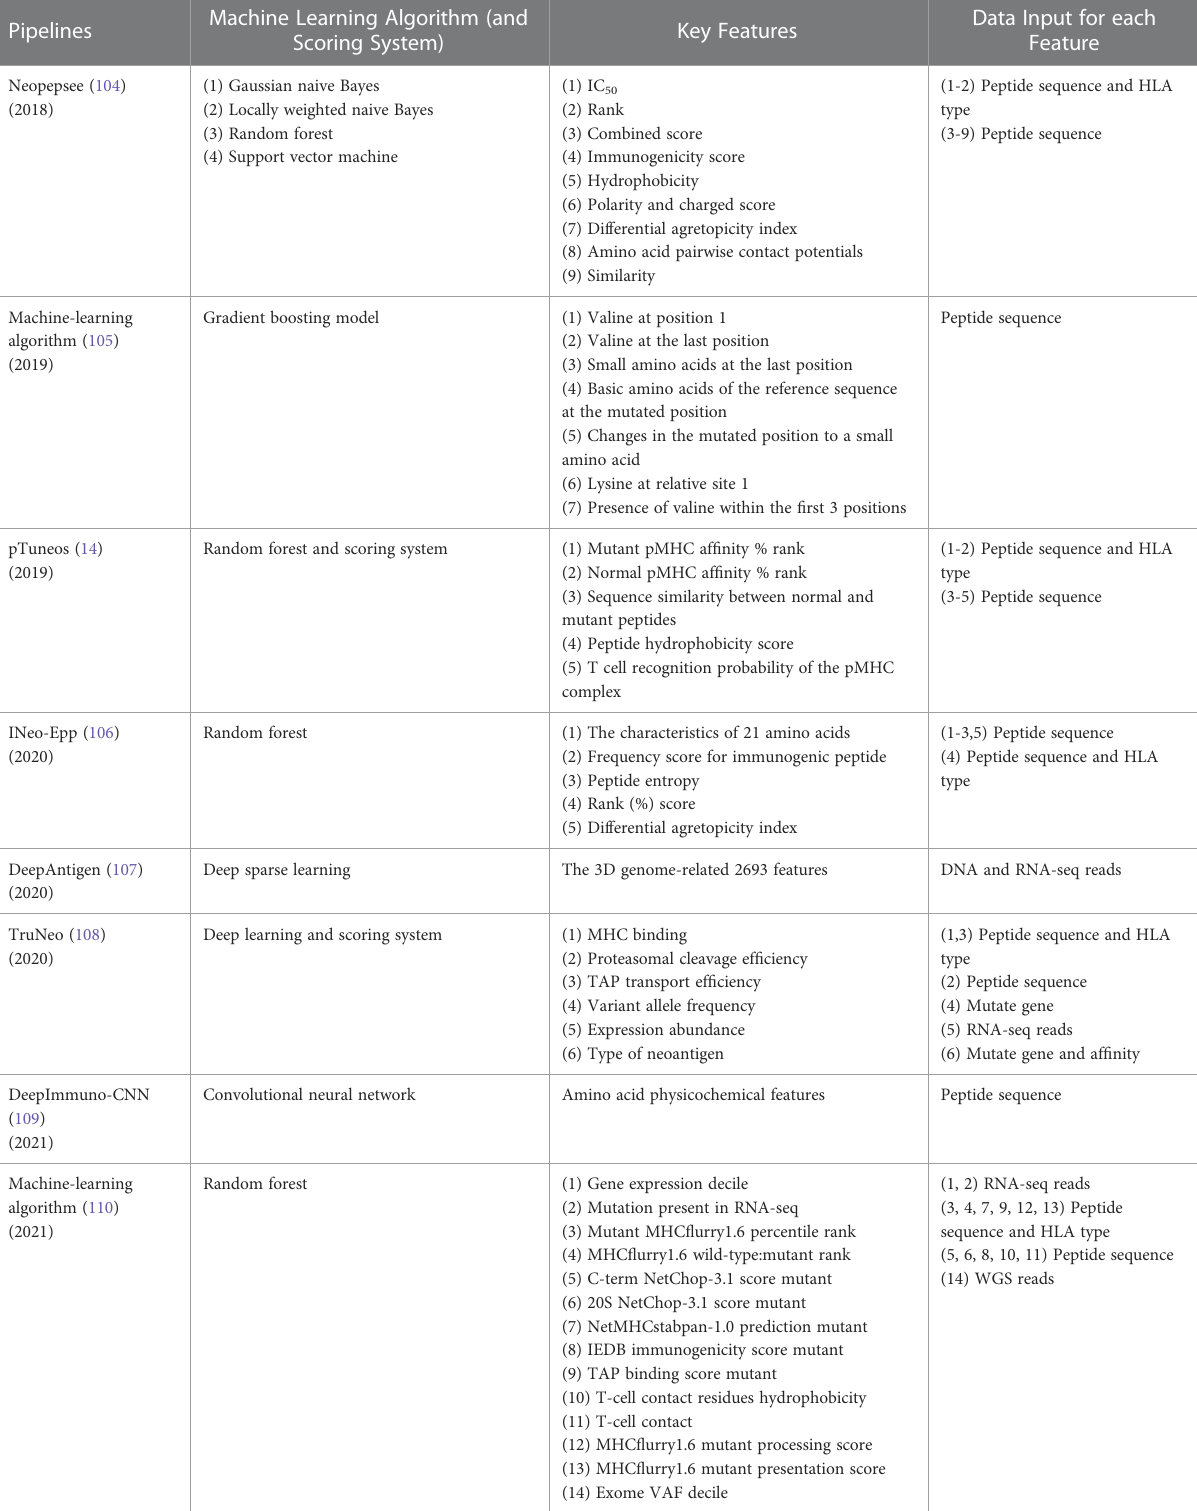
TABLE 2 Pipelines with ML models extracting binding af fi nity and immunogenicity